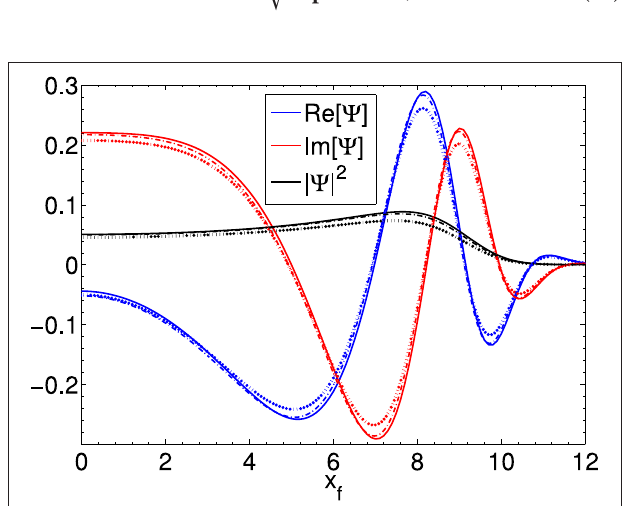
FIGURE 3 | Re [ 9 ], Im [ 9 ], and | 9 | 2 are shown for the free particle case at t = 10 ¯ h / m as a function of x f , which also has units of ¯ h / m . The solid lines show the Schrödinger solution, while dotted lines and dashed lines show the WKB approximation for ǫ 0.05, ǫ 0.005, respectively. It can be seen = = that as ǫ 0 the WKB approximation converges to the Schrödinger →